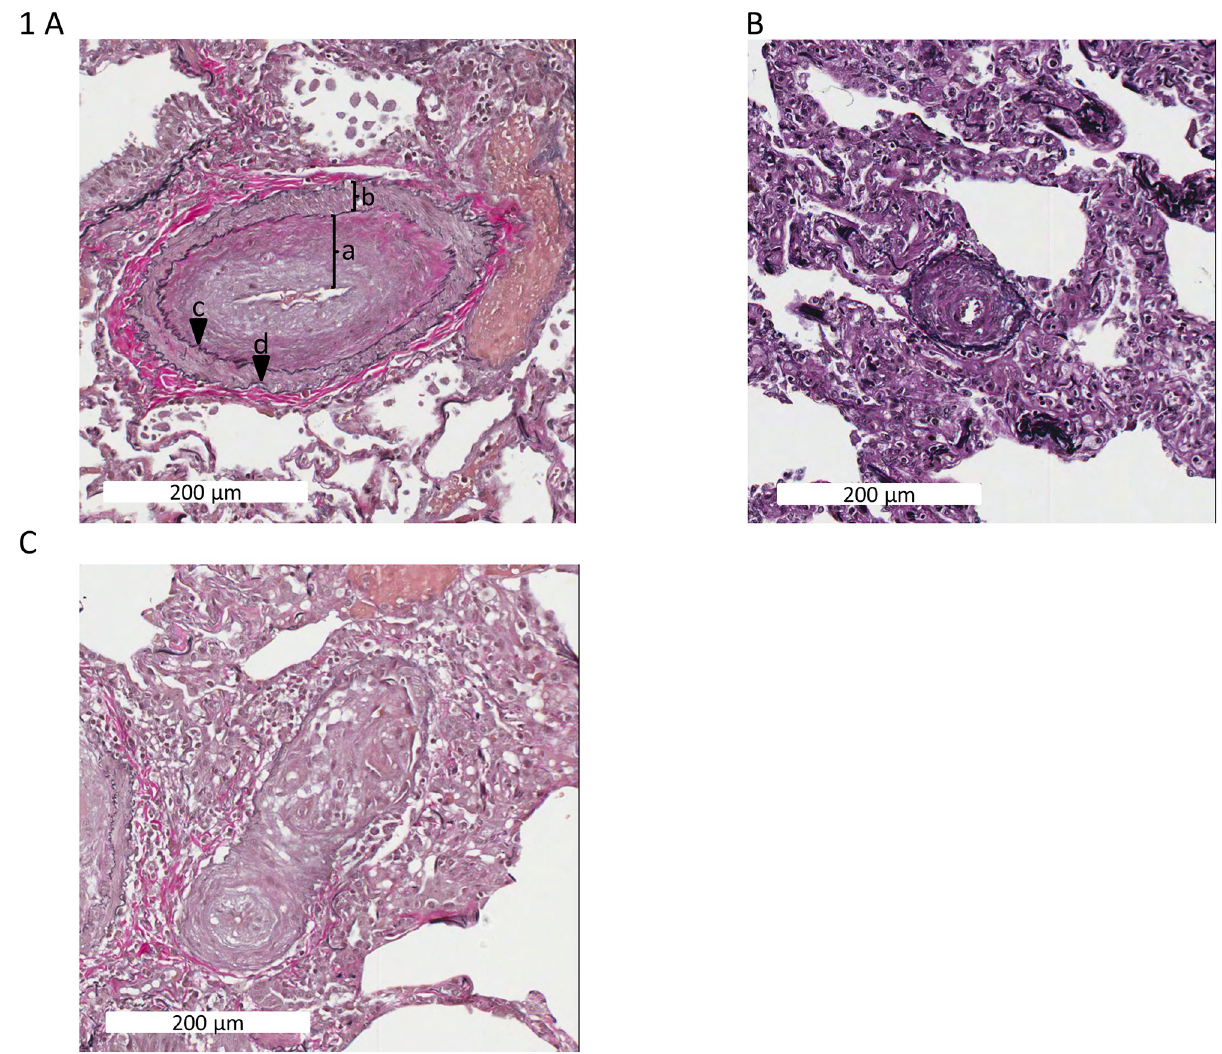
Fig 1. Characteristic histology of PAH vessel remodelling. (A) Fibroelastic intimal hyperplasia [a) Intima; b) Muscularis media; c) Elastic interna; d) Elastica externa]. (B) Concentric medial hyperplasia (C) Angiomatoid lesion; Elastica van Gieson; Scale bar 200 μ m in A and C, 100 μ m in B.